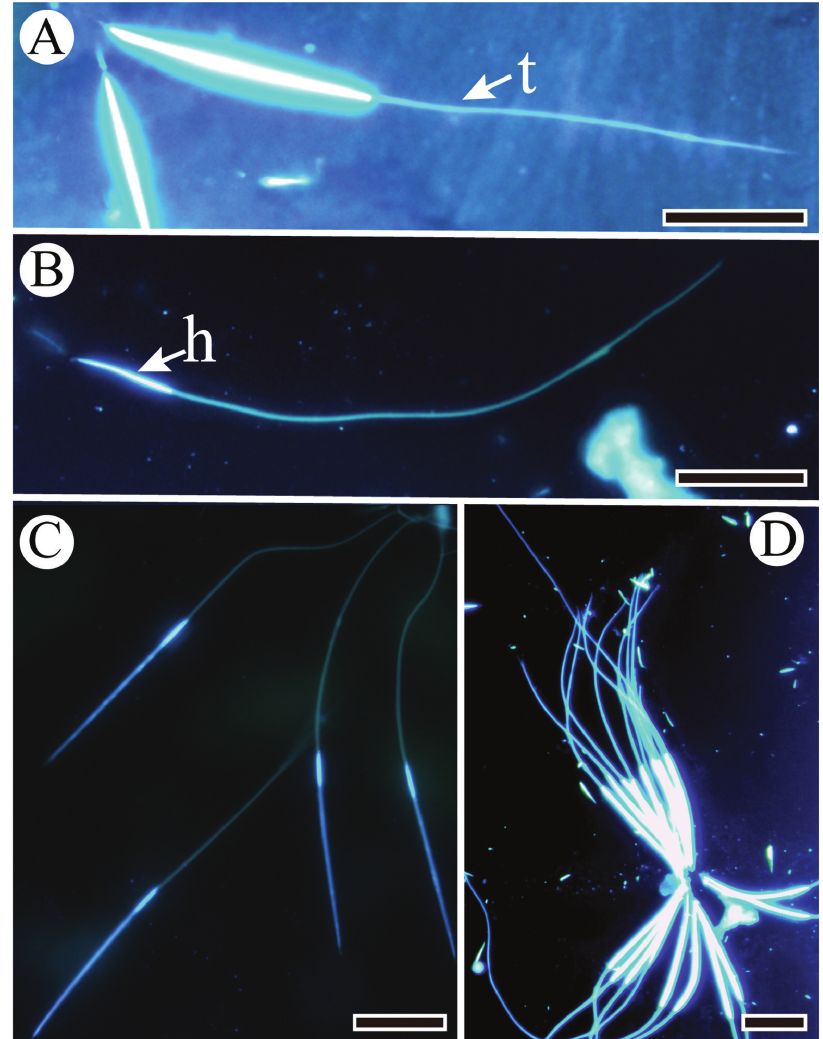
Figure 1. Epifluorescent microscope images of spermatozoa stained with Hoechst 33258. A Spermato- zoon of Subpsaltria yangi with a head and a tail (t) B Spermatozoon of Platypleura kaempferi with a short head (h) and an elongated tail C Slender spermatozoa of Karenia caelatata with a head and a tail D Sper- matozoa of S. yangi aggregated into bundles. Scale bars: 20 Table 2. Total sperm length (μm) (mean ± SE) of three cicada species. Length of long Length of medium Length of short Species Length range N spermatozoa spermatozoa spermatozoa Subpsaltria yangi 105.90 ± 2.96 83.25–195.34